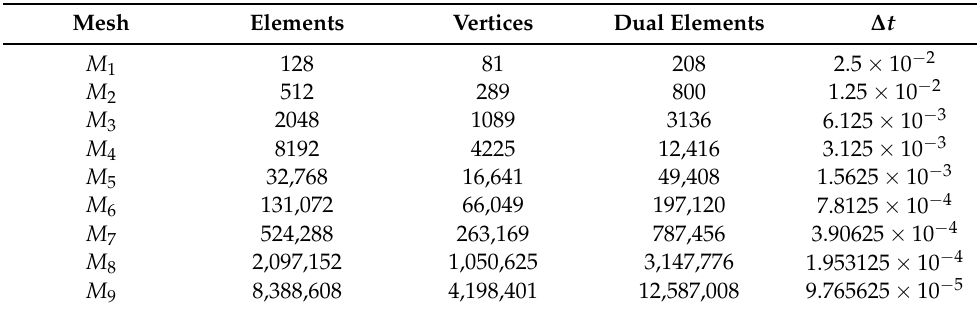
Table 1. Description of the meshes and time steps used to perform the convergence analysis with the Taylor-Green vortex benchmark in 2D.